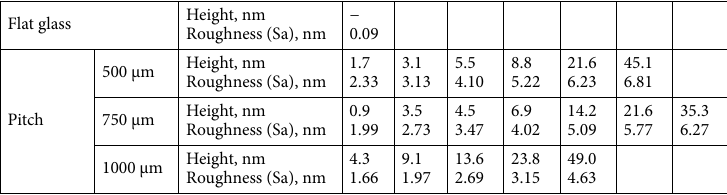
Table 1. Surface parameters of glass surfaces considered as writing-surface